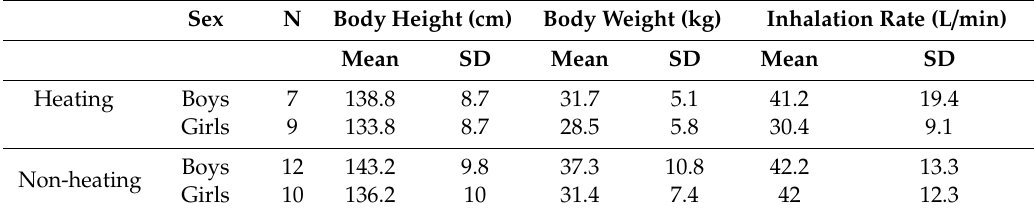
Table 2. Parameters for children in the heating and non-heating